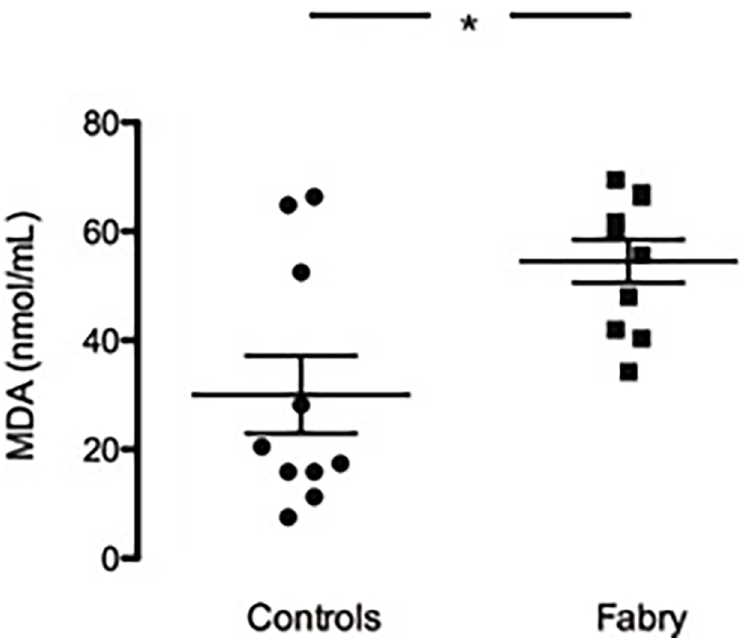
Fig 3. Lipid peroxidation state. Colorimetric analysis of MDA concentration (nmol/mL) in Fabry subjects (Fabry) compared to healthy subjects (Controls). Data are shown ± SEM. (cid:3) : p = 0.01.